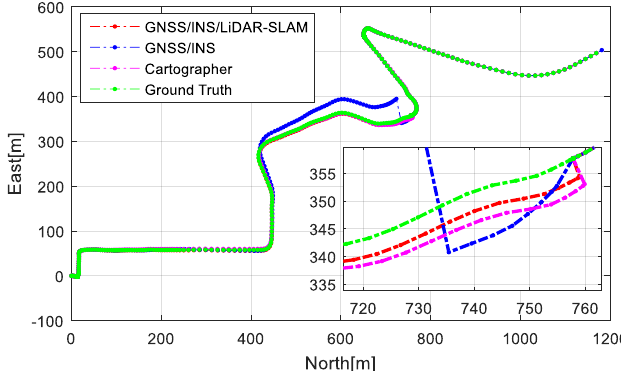
Figure 13. Trajectories in the urban area test.